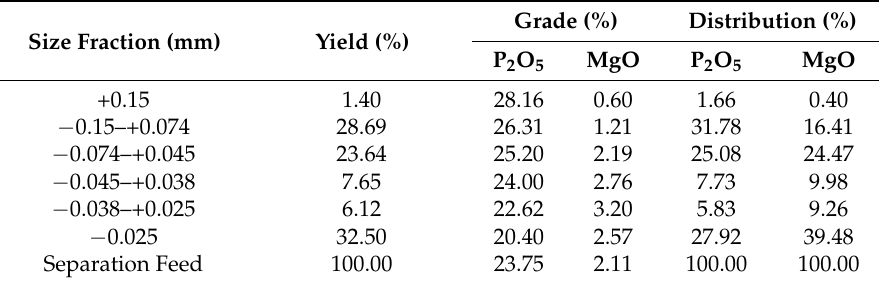
Table 3. Grain analyses of separation